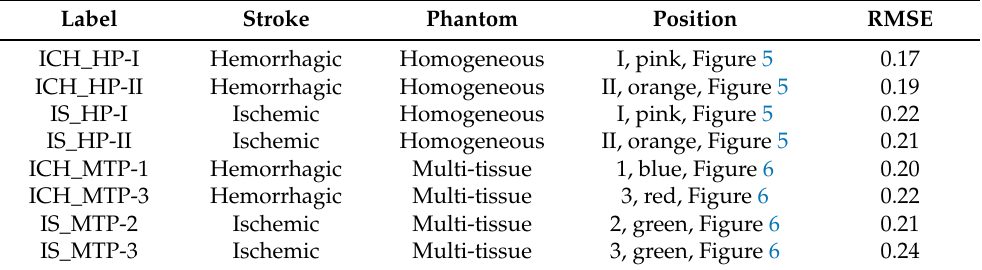
Table 1. Description of all of the considered cases.